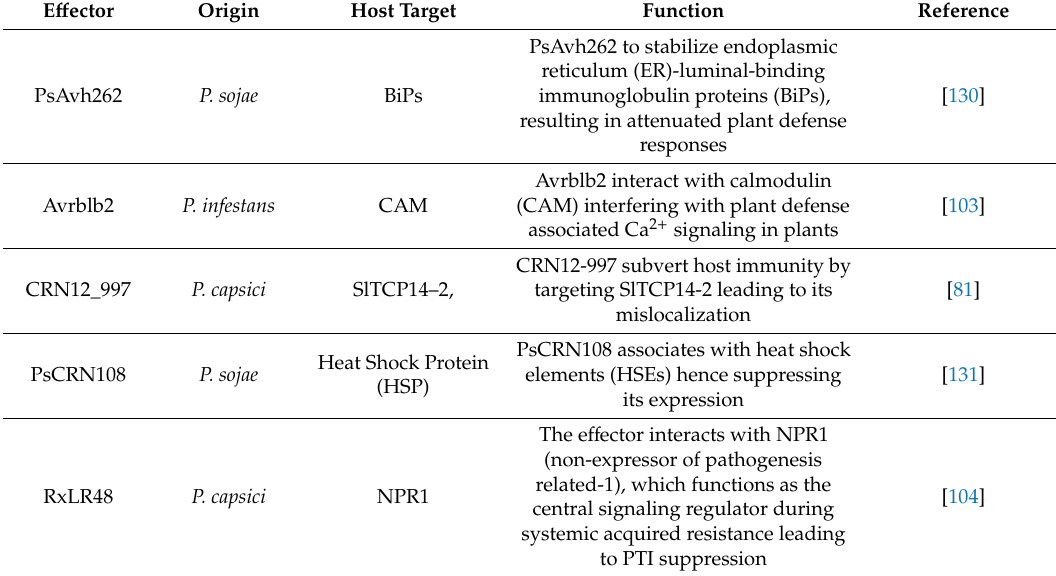
Figure 2. Proposed model of Phytophthora cytoplasmic e ff ectors localizing to di ff erent subcellular compartments as they act on various plant proteins that are key in immune system. Most RxLR e ff ectors target positive regulators of the plant immunity while a few of them target negative regulators / susceptibility factors in asterisks (*). The arrow ( → ) denotes e ff ector subcellular relocalization, while ( (cid:97) ) designates e ff ector-target interaction. Table 4. Host cytoplasmic e ff ector targets in Phytophthora